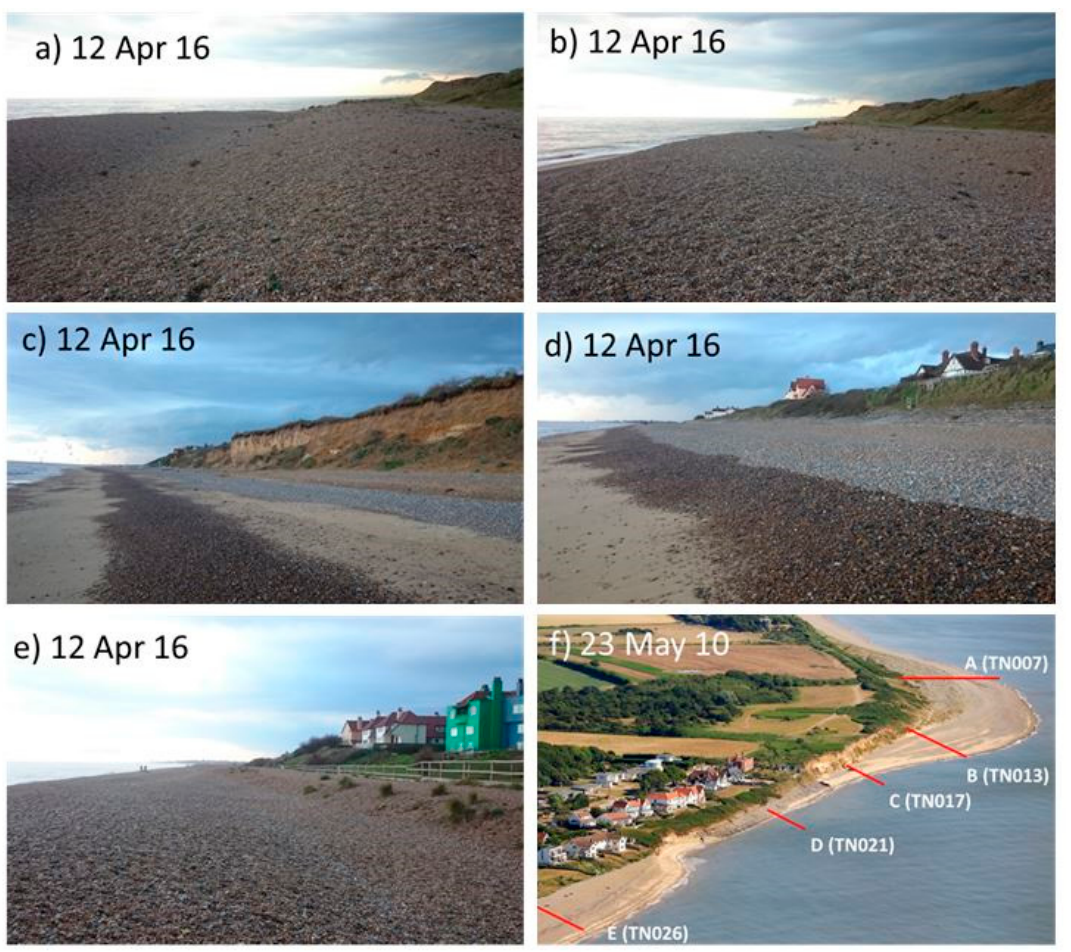
Figure 3. ( a – e ) Beach morphology along transects A to E (respectively), and ( f ) their approximate location within the study area shown on an oblique aerial photograph taken after an intense erosion event in 2010 (photos a–e by L.S. Esteves; f by